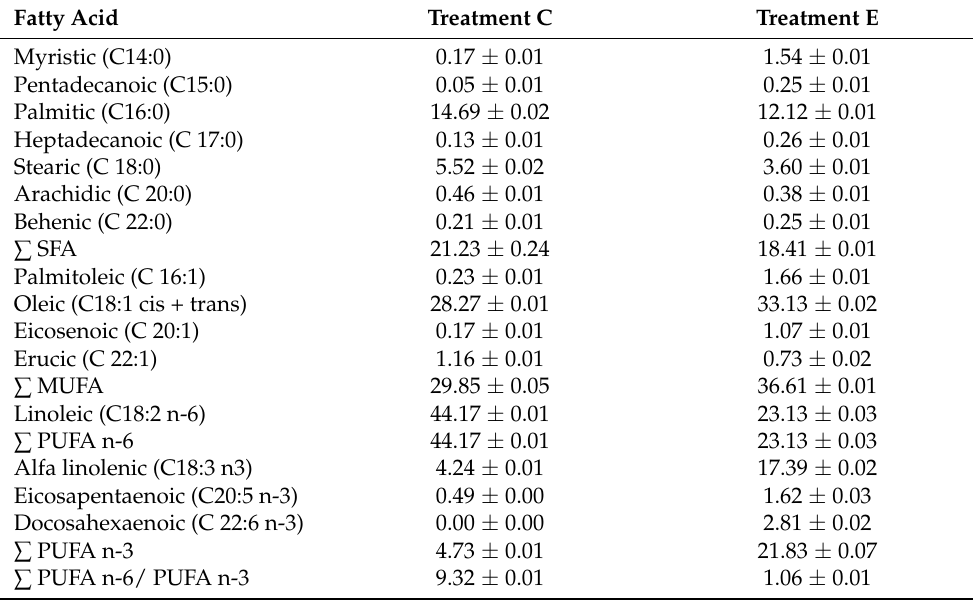
Table 2. The content of fatty acids in feeding mixtures (% in the sum of fatty